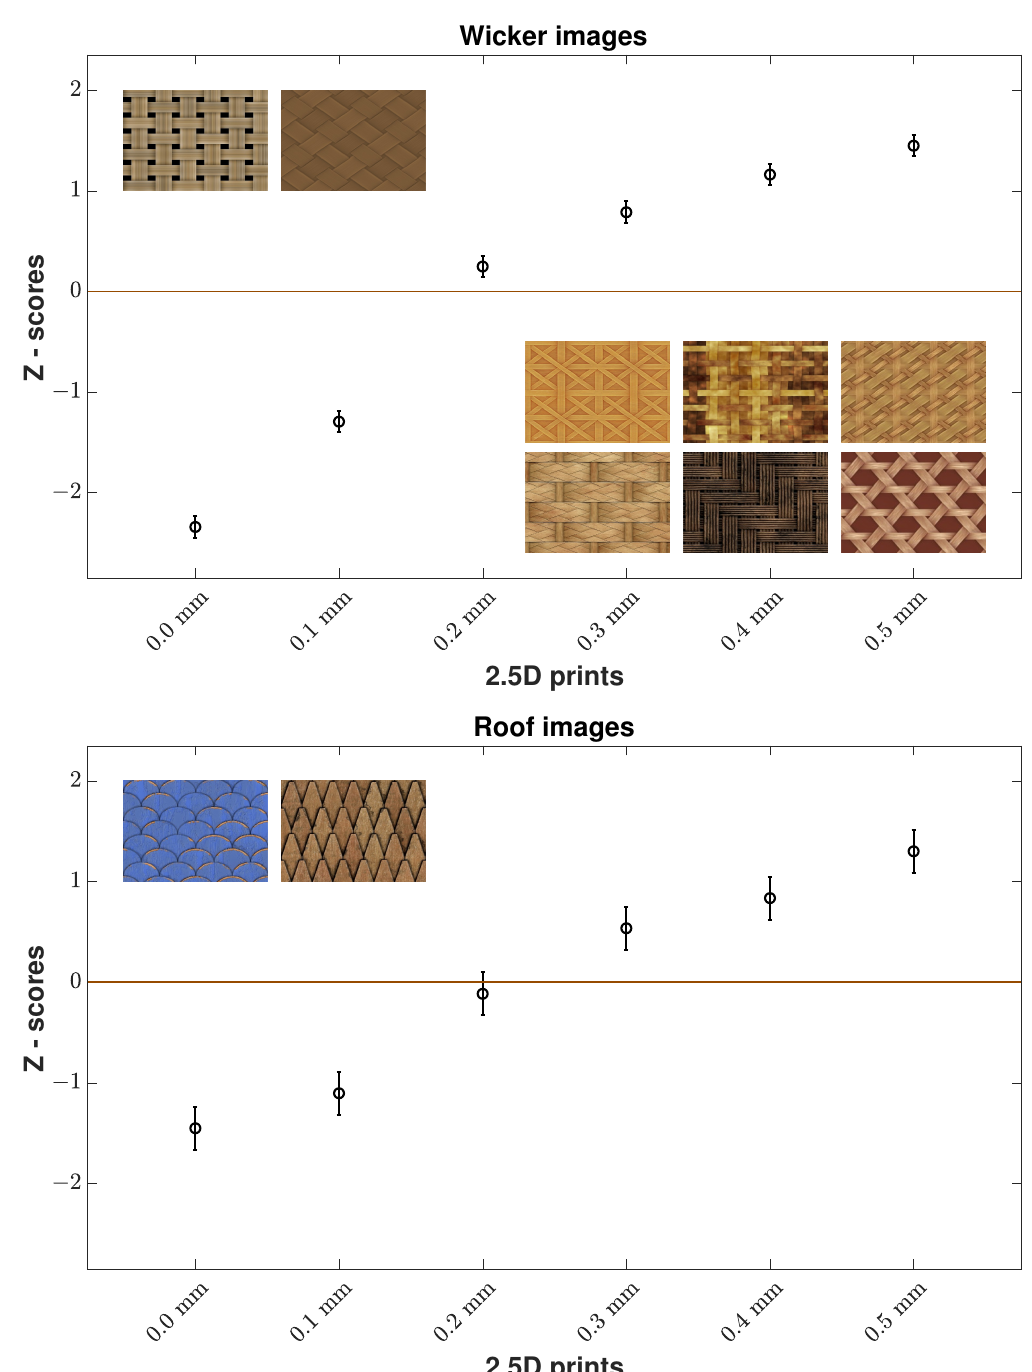
Figure 5. Z-scores of all wooden wicker and all wooden roof images by all observers. Mean Z-score values for 2.5D prints at various elevation levels (x-axis) are given with 95% CI s. We can observe that for both wicker and roof images, the observers found 2.5D prints with 0.5 mm as the most natural. There are 8 wicker and 2 roof